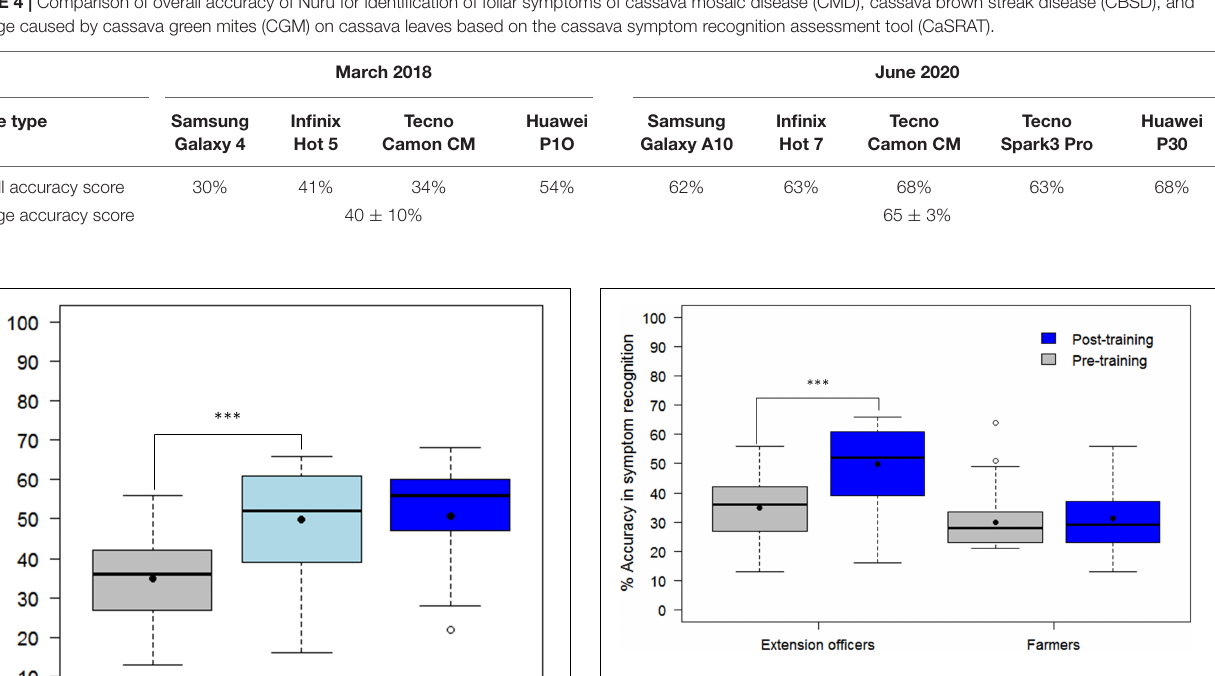
FIGURE 5 | Comparison of the ability of 30 agricultural extension officers to accurately recognize symptoms of CMD, CBSD, and CGM-damage before and after receiving training on cassava pests and diseases as well as after using the PlantVillage Nuru app for diagnosing cassava diseases. The black line within the boxes represents the median, the top and bottom of the box represent the 75th and the 25th percentile, the whiskers represent the maximum and minimum values while the symbols ( ) and ( (cid:13) ) represent the mean and the (cid:32) ) and ( (cid:13) ) (cid:32)